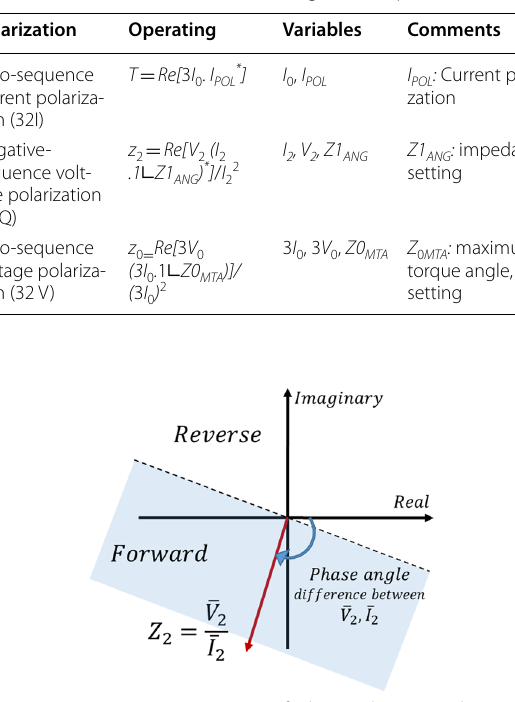
Fig. 9 Apparent negative-sequence fault impedance seen by 67Q